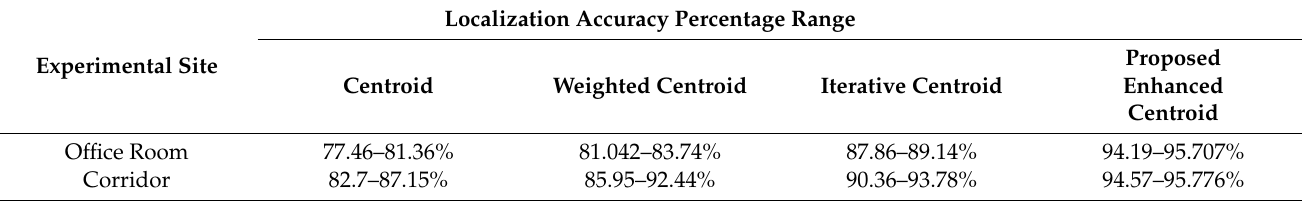
Table 4. The localization accuracy percentage range of the four positioning algorithms at the two experimental sites.